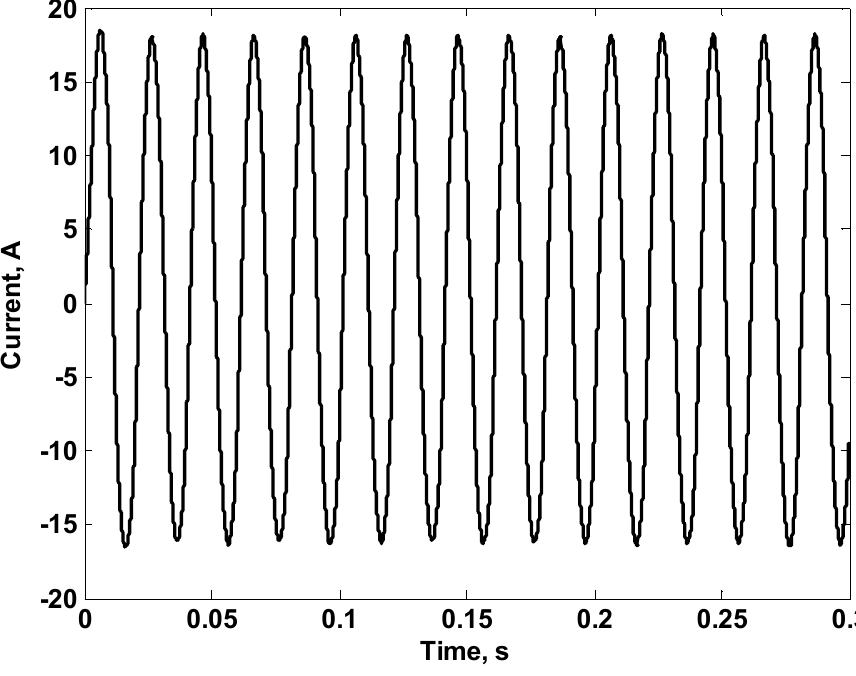
Figure 11. A 50 Hz Load Current.